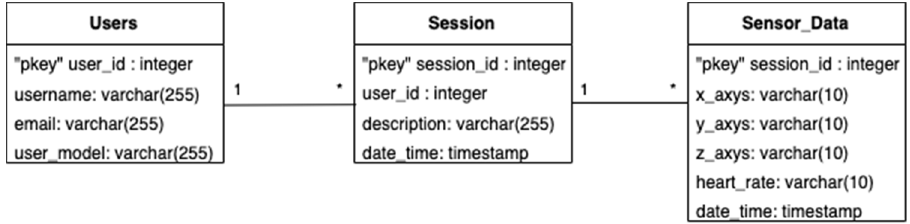
Figure 24. Database structure for meditation practices.